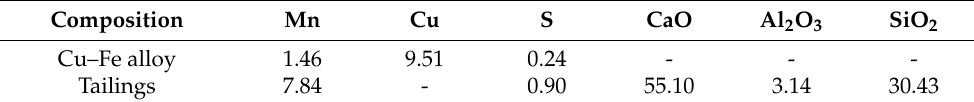
Table 2. The composition of Cu–Fe alloy and tailings after desulfurization by Fe–Mn (wt.%).